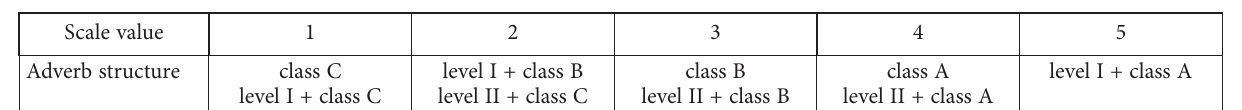
Table 4. Summary table of adverb structure and its assignment